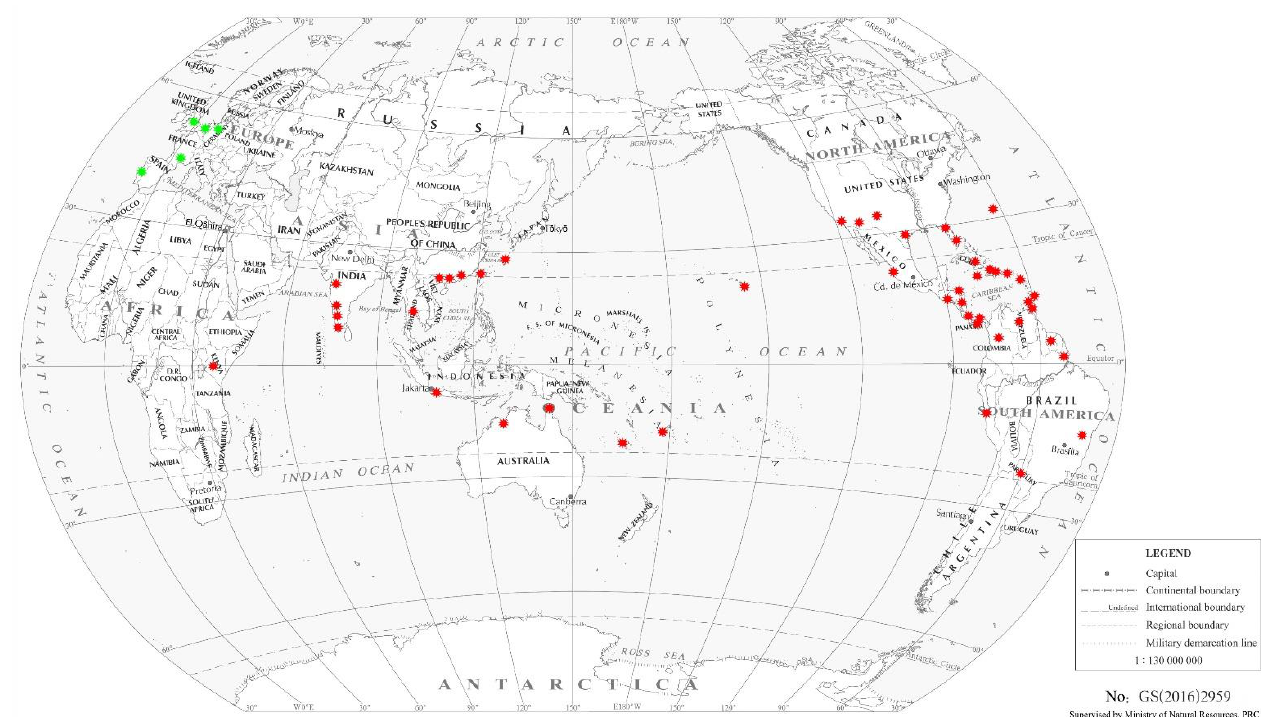
Figure 1. Known global distribution of Franklinothrips vespiformis . Red spots indicate locations with wild populations; green spots indicate artificial releases.